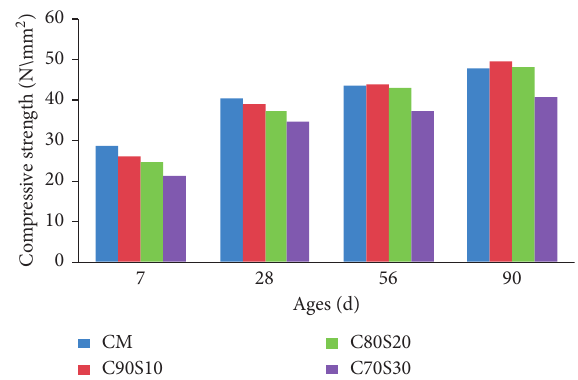
Figure 3: Compressive strength of concrete mixes at various curing ages.